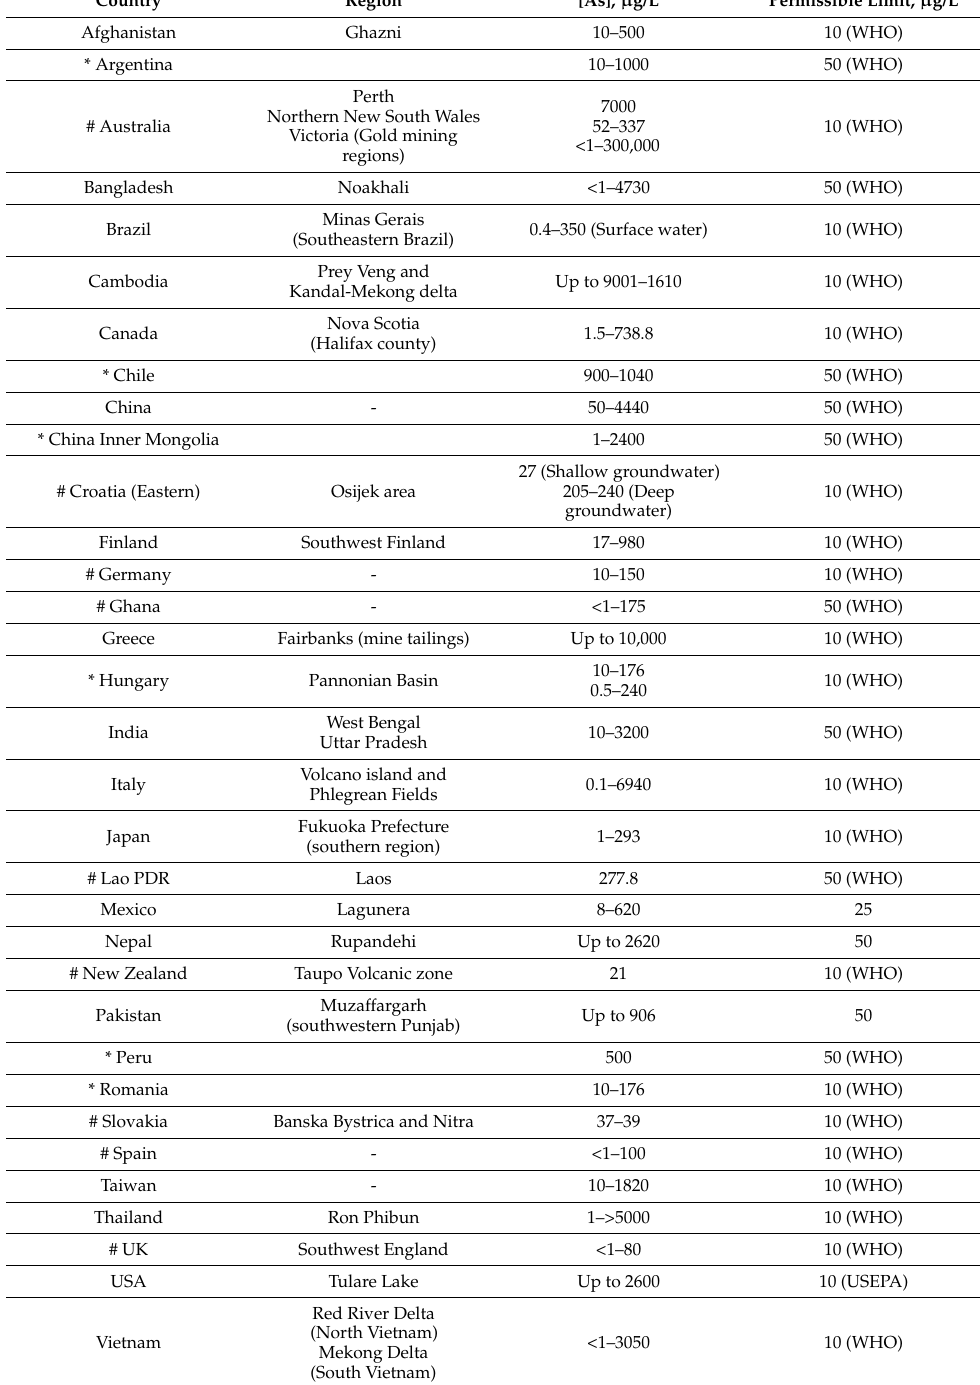
Table 1. Global variation of arsenic concentrations in